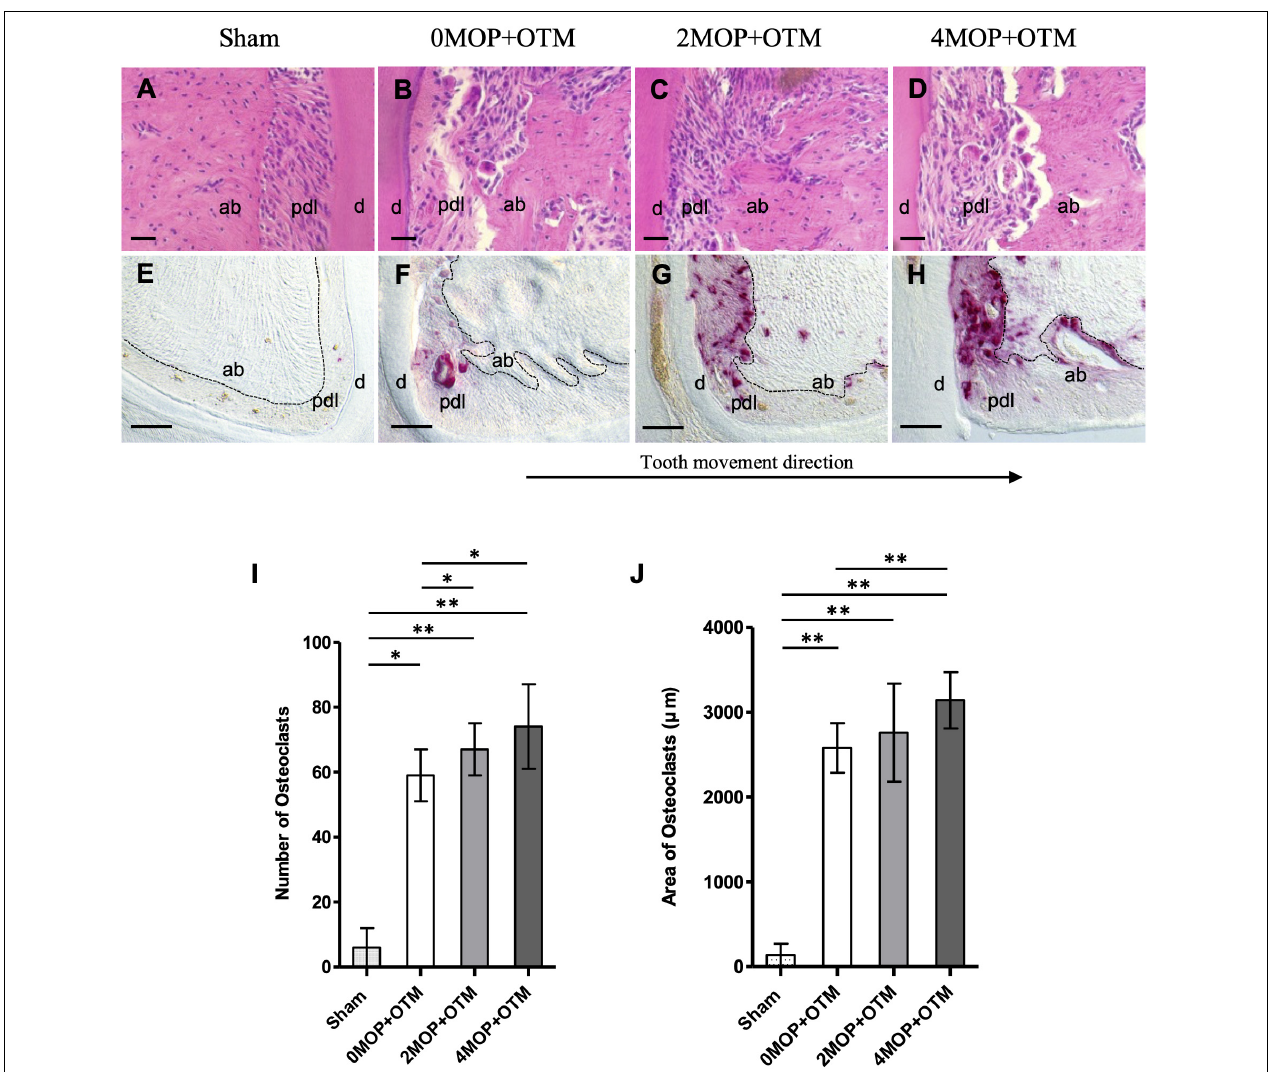
FIGURE 4 | Morphological changes and osteoclast activity. (A–D) H&E staining show the morphological changes on the compression site of the distal root after the experimental period. (E–H) TRAP staining shows the comparison of the osteoclast activity among groups. (I) Quantification analysis of the number of osteoclast cells showed an increase in the 2MOP+OTM group (67 ± 8; p < 0.05) and 4MOP+OTM group (74 ± 13; p < 0.05) compared with the 0MOP+OTM group (59 ± 8). Sham group (6 ± 6; p < 0.01) was significantly lower than other groups. (J) The area of osteoclasts was increased in the 4MOP+OTM group (3141.76 ± 330.67 µ m; p < 0.01) compared with the 0MOP+OTM group (2577.52 ± 291.84 µ m). Further, the Sham group (136.05 ± 132.17 µ m; p < 0.01) was significantly lower compared with other groups. ( N = 8/each group) (d, dentin; pdl, periodontal ligament; ab, alveolar bone; dashed lines, outline of PDL area; Scale bars = 30 µ m (A–D) ; Scale bars = 50 µ m (E–H) ; data are expressed as mean ± standard deviation. Tested by Mann-Whitney U test, at ∗ p < 0.05; ∗∗ p <